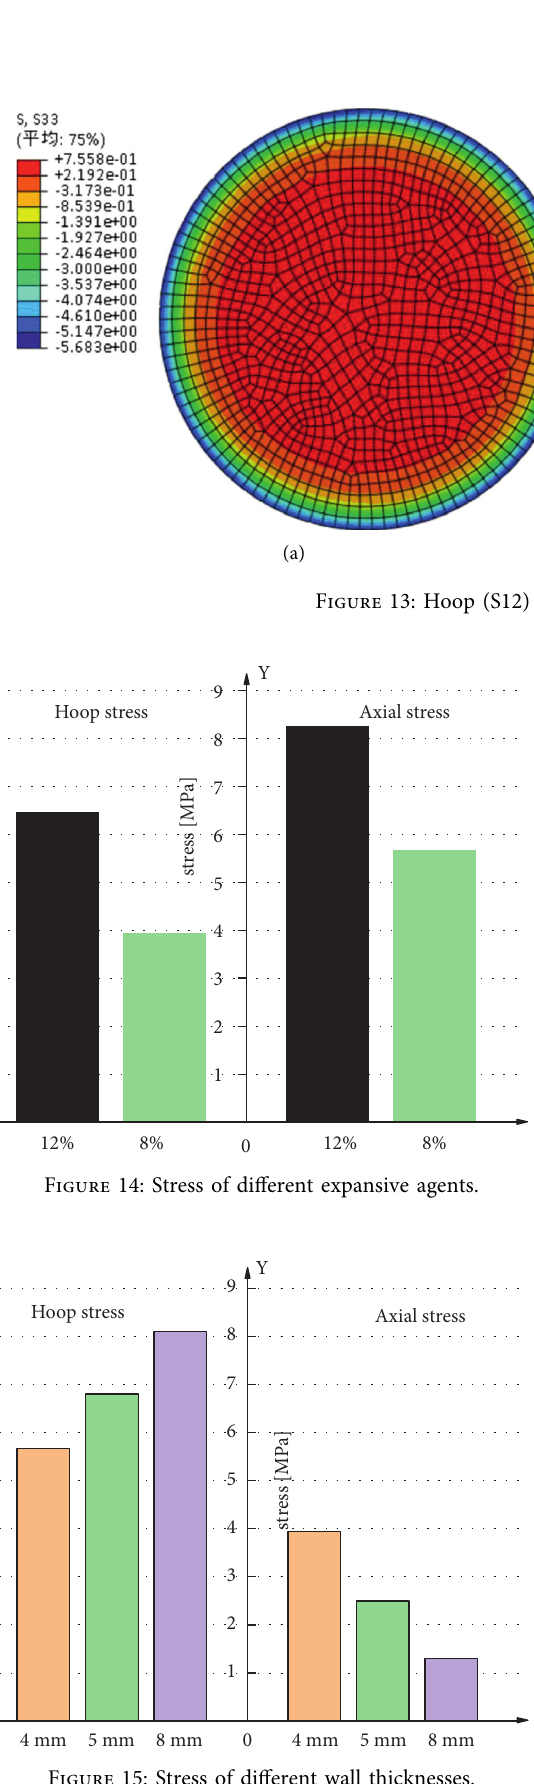
Figure 15: Stress of different wall thicknesses.